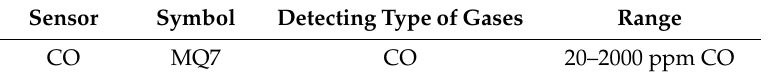
Figure 4. The position of CO sensor on the mask. Table 1. The MQ7 sensor parameters 27.